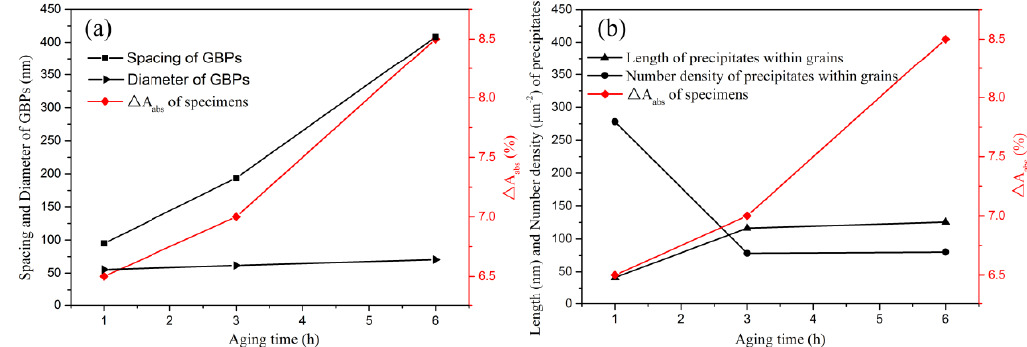
Figure 9. Evolution of ductility index, ∆A abs , with ( a ) spacing and diameter of GBPs and ( b ) length and number density of precipitates within grains.